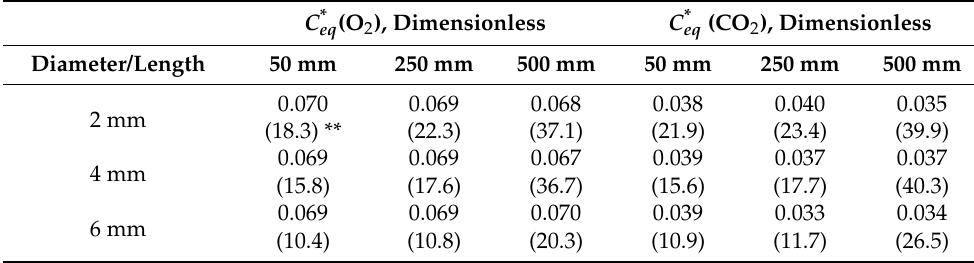
Table 1. Equilibrium parameters C ∗ eq (O 2 ) and C ∗ eq (CO 2 ) calculated for tubes of different dimensions. C * eq (O 2 ), Dimensionless C * eq (CO 2 ), Dimensionless